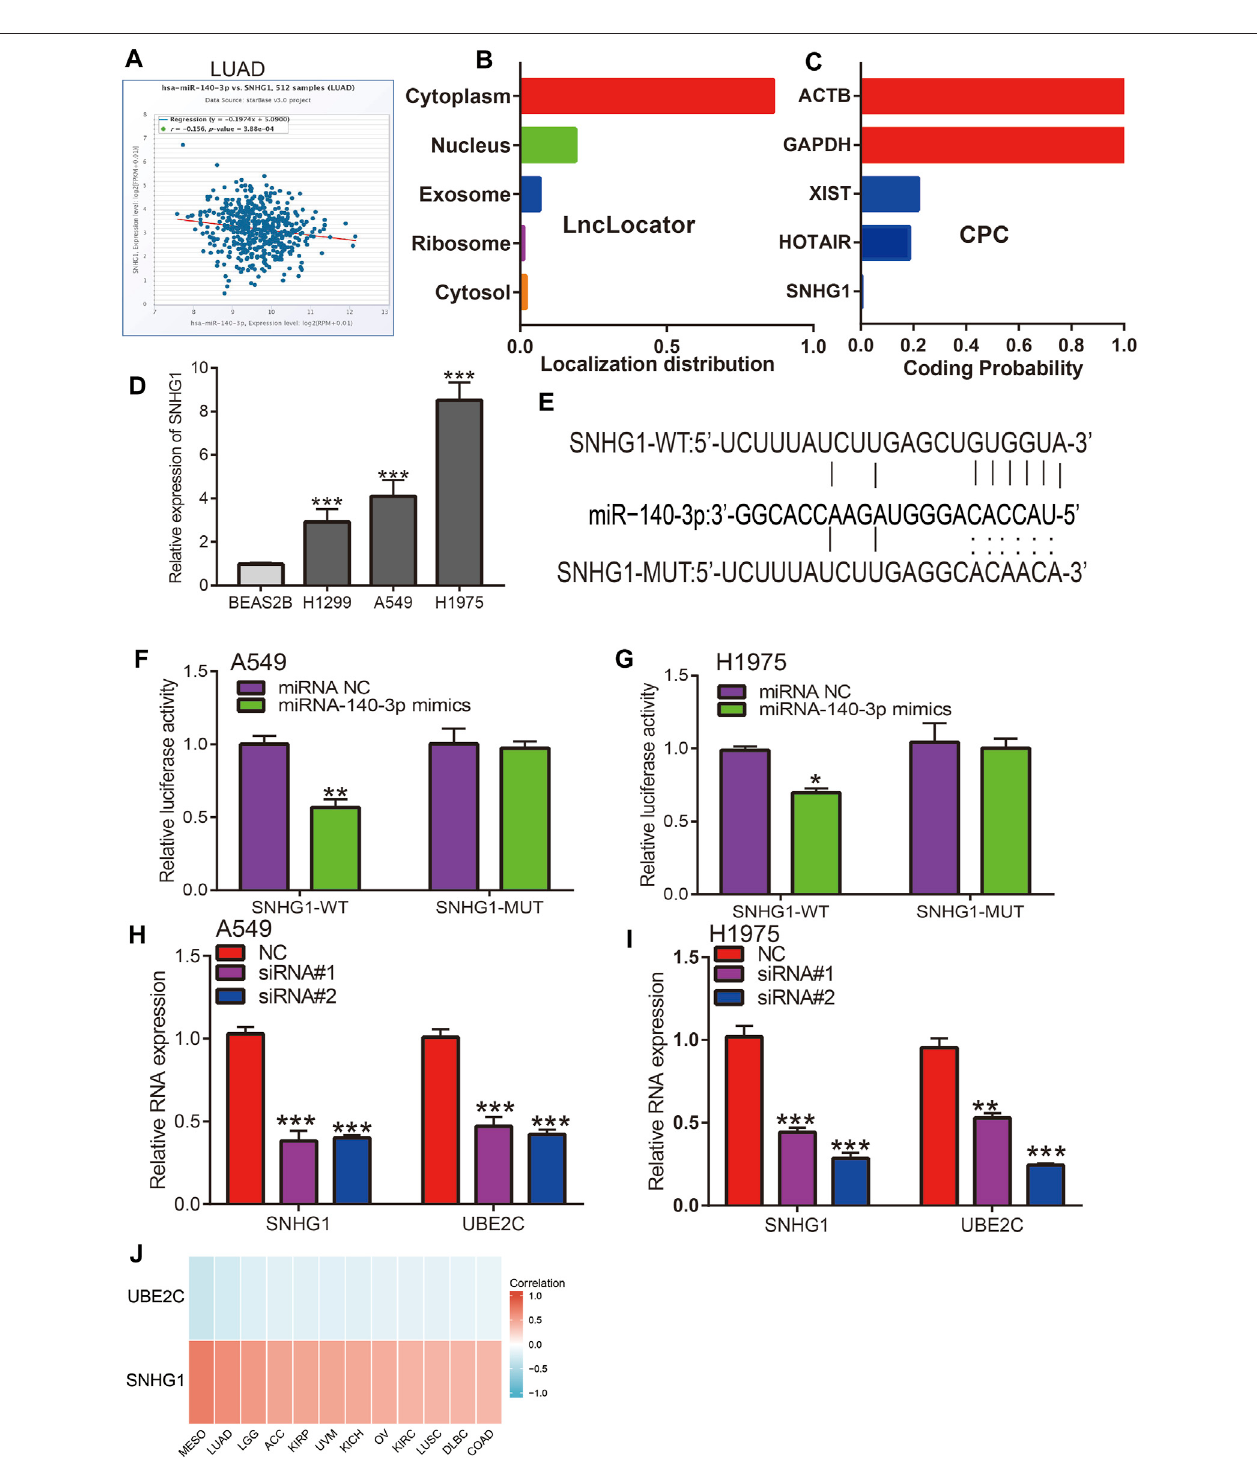
FIGURE 9 | Analysis of upstream lncRNA of miRNA-140-3p in pan-cancer. (A) The correlation between the SNHG1 and miRNA-140-3p in LUAD analysis by Starbase. (B) The subcellular localization of SNHG1 examined by lncLocator. (C) The coding potential of SNHG1 analysis by coding the potential calculator. (D) The expression of SNHG1 in NSCLC cell lines examined by qRT-PCR assay. (E) The target sites between miRNA-140-3p and SNHG1 was predicted by Starbase. (F,G) Relative luciferase activities of wild-type (WT) and mutated (MUT) SNHG1 reporter plasmid in A549 and H1975 cells co-transfected with miR-140-3p mimics examined by luciferase reporter assay. (H,I) The expression of UBE2C after depletion of SNHG1 in NSCLC cell lines examined by qRT-PCR assay. (J) The correlation between miRNA-140-3p and UBE2C, SNHG1 in NSCLC examined by Starbase. * p < 0.05, ** p < 0.01, *** p < 0.001.